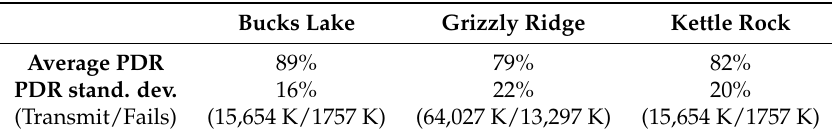
Table 6. Measured average PDR over the three deployment sites.